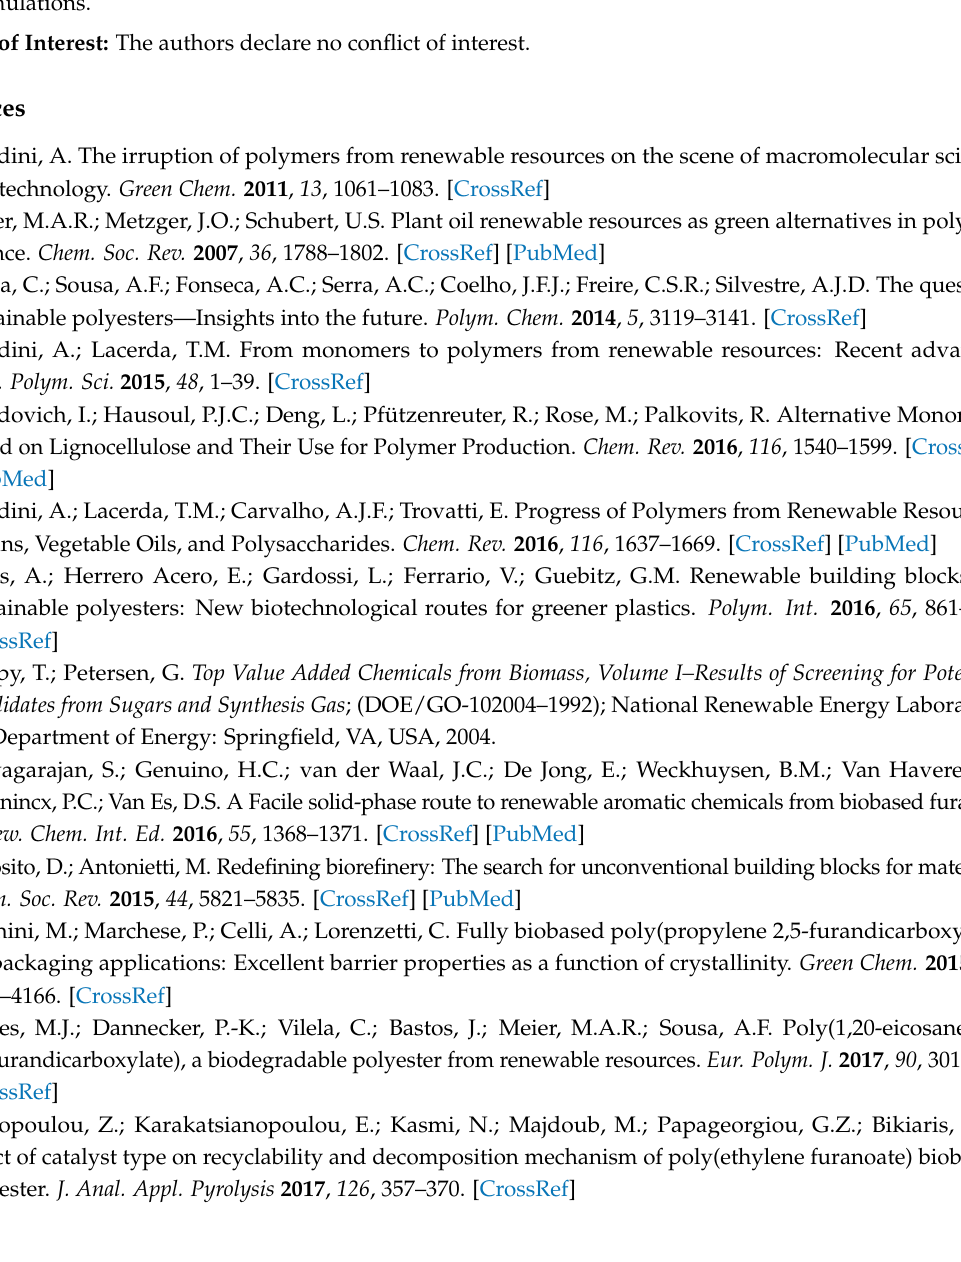
Figure S1: DSC thermograms of PEF/TBT.1 samples prepared after SSP at different temperatures and times, Figure S2: DSC thermograms of PEF/TBT.2 samples prepared after SSP at different temperatures and times. Author Contributions: D.N.B. and G.Z.P. conceived of and designed the experiments and participate to paper writing; N.K. performed the experiments and participate to paper writing; D.S.A. performed all the kinetic model